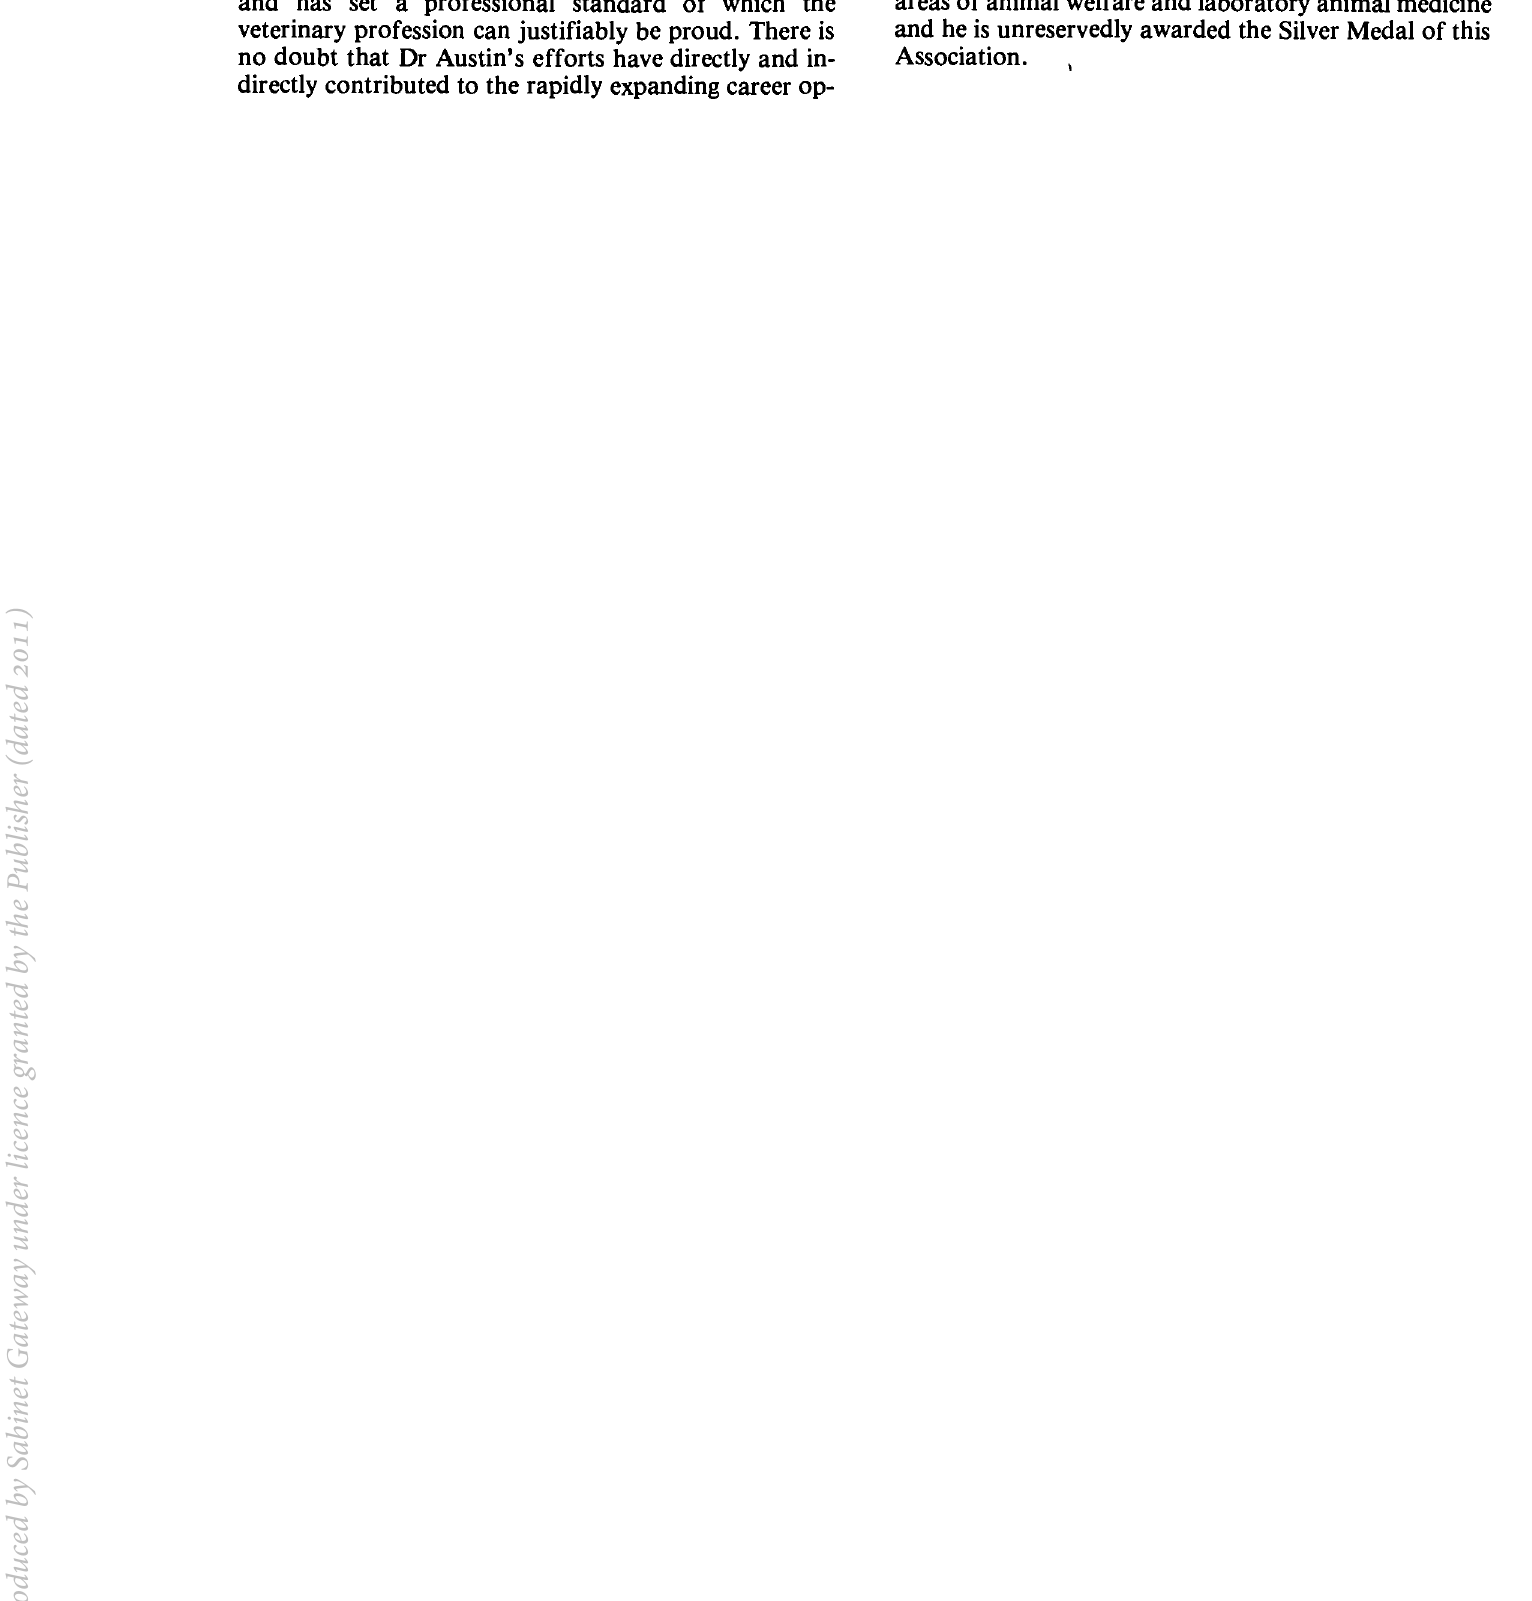
TYDSKRIF VAN DIE SUID-AFRlKAANSE VETERINERE VERENIGING - DESEMBER